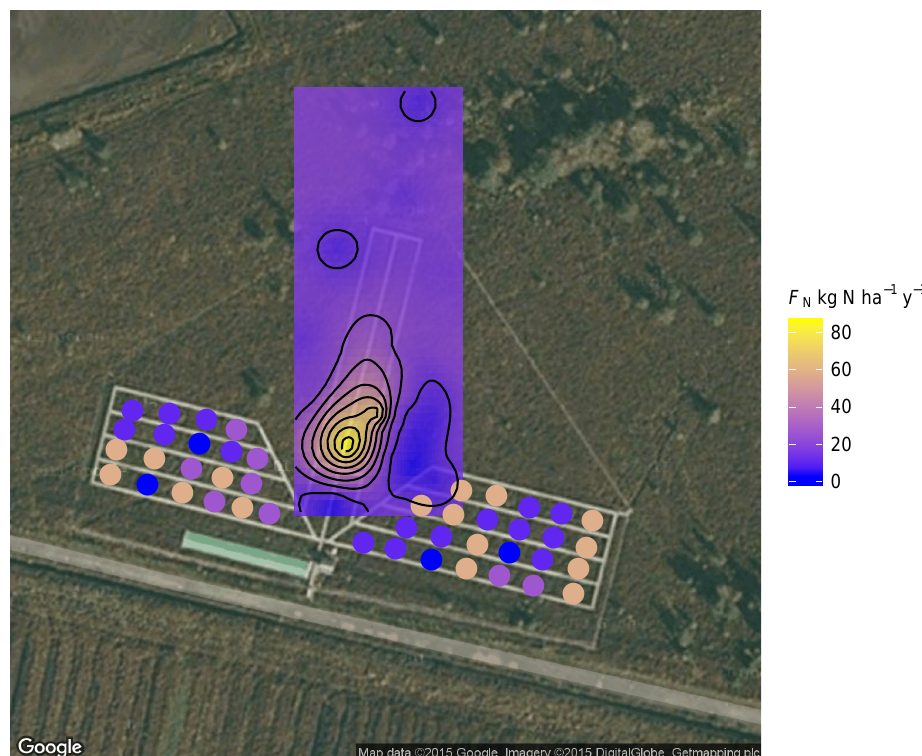
Figure 1. Spatial distribution of N deposition in the Whim experiment. The ammonia release system was located at the centre of the boardwalk structure in the middle of the image. Ammonia deposition was calculated from concentration measurements downwind of the ammonia source using the method of Cape et al. (2008), and interpolated across the central rectangular area of the image using ordinary kriging. In the wet deposition plots (circles in the lower part of the image), the nitrogen solution applied was sprayed evenly across the whole 12.8m 2 plot. North is at the top of the